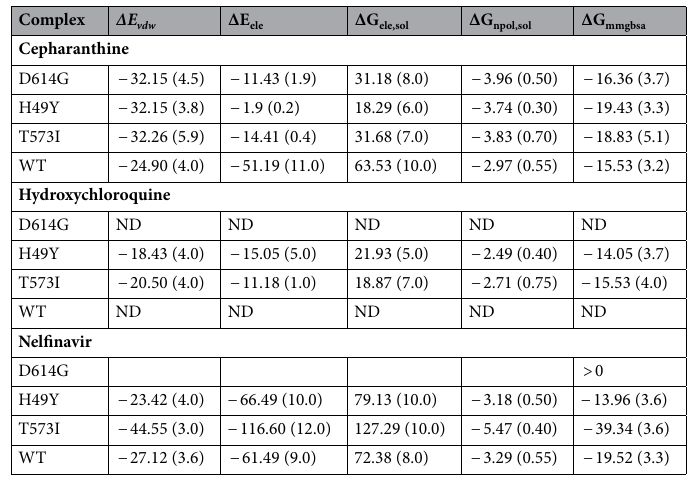
Table 1. Binding free energy components of complexes between ligands and SARS-CoV-2 spike protein (kcal/ mol). All energies are averaged over 200 snapshots at time intervals of 100 ps from the last 20 ns-long MD simulations, and they are in kcal/mol (± standard deviation). ND due to ligand diffuses of the binding pose at the first ns of